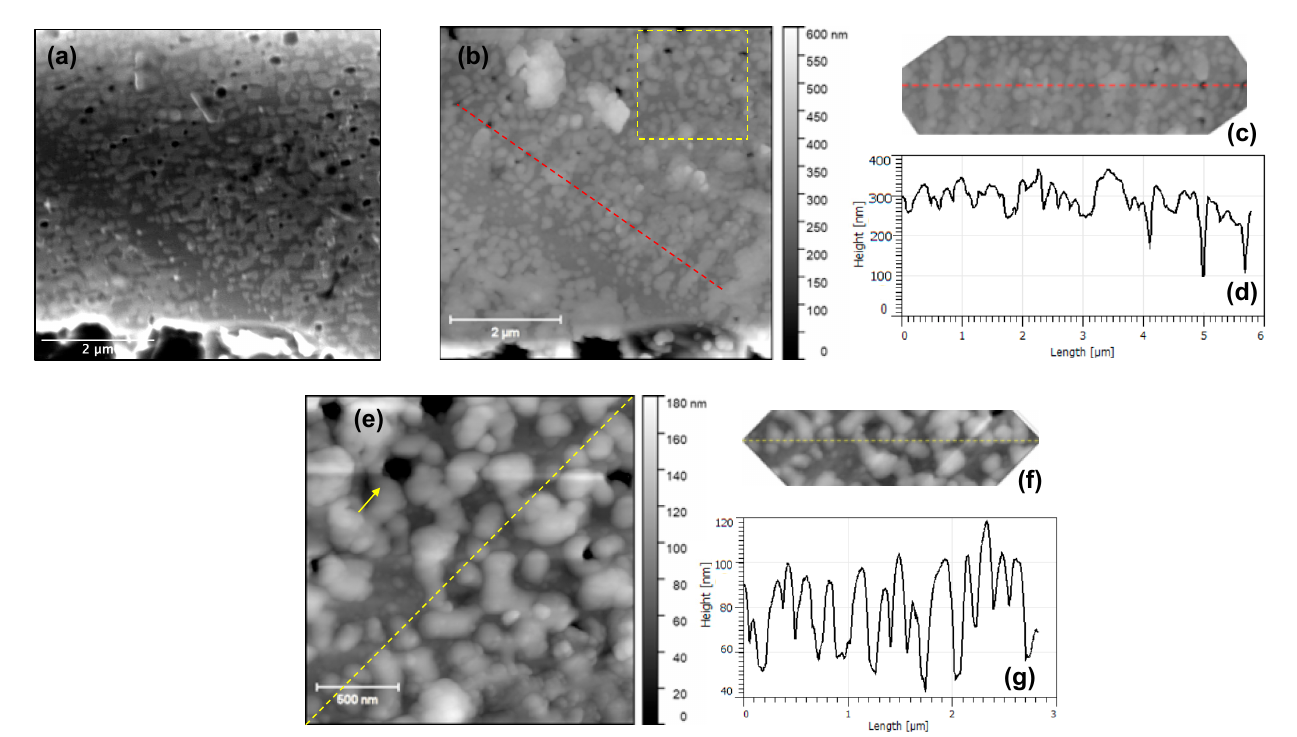
Figure 6. ( a ) Plan-view SEM micrograph of a region with arrays of nano-dots (a micro-crucible with a large opening, the solid green box in Figure 5(b)). ( b ) AFM micrograph of the same region in ( a ). The dashed red line shows a region of interest, cropped and realigned in ( c ) with the resulting height profile shown in ( d ). ( e ) A higher resolution AFM micrograph of the region in the dashed yellow box in ( b ). The yellow arrow highlights the formation of ring-like structures, i.e., when several nano-dots agglomerate with a pit presence in the middle. Meanwhile, the dashed yellow line shows a region of interest for a height profile analysis, cropped and realigned in ( f ), in which the resulting height profile is shown in ( g ).